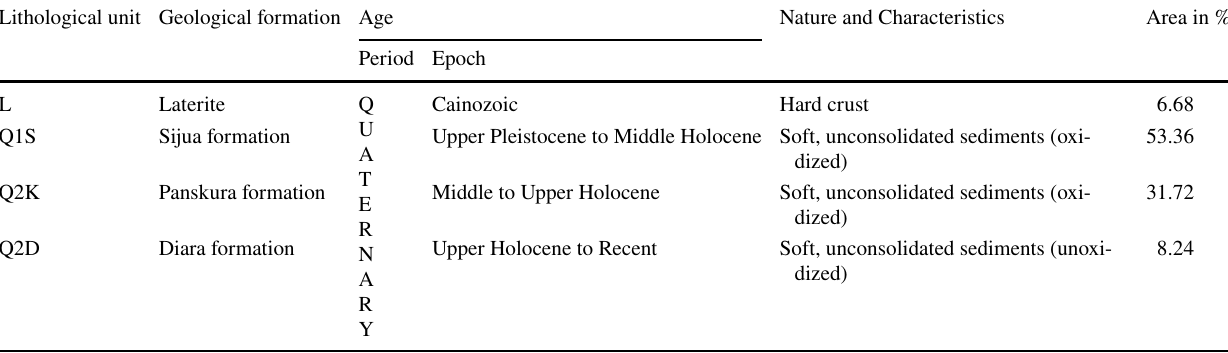
Table 2 Details of the lithological unit in geological framework Lithological unit Geological formation